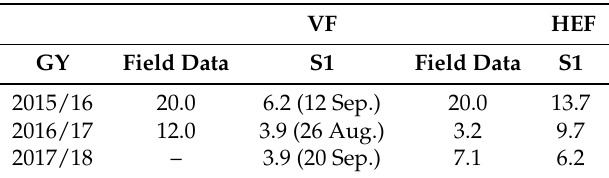
Table 4. Annual accumulation area ratio (AAR) estimates from field data and annual minimum in wet snow covered area fraction determined from Sentinel-1 (S1) scenes with date of acquisition in brackets per glaciological year (GY) and area of interest Vernagtferner (VF) and Hintereisferner (HF). All values are presented in percent